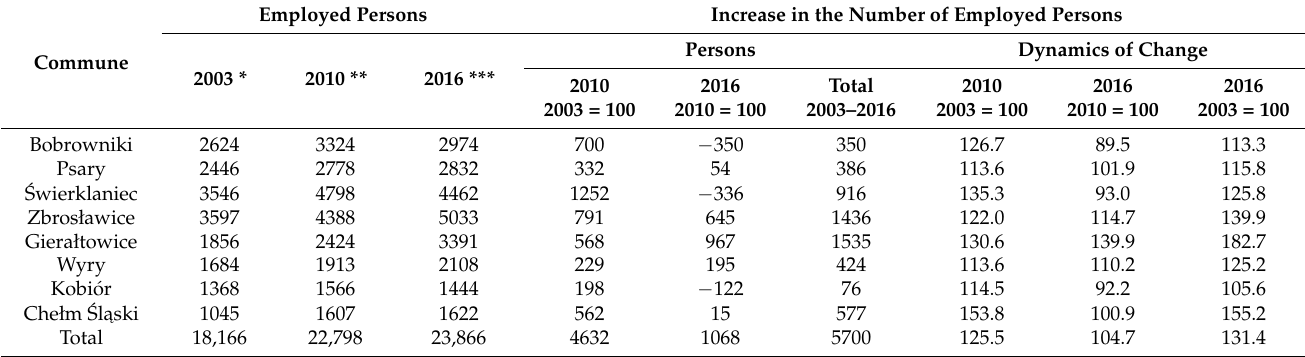
Table 2. Local labour market in rural communes in 2003, 2010, and 2016.